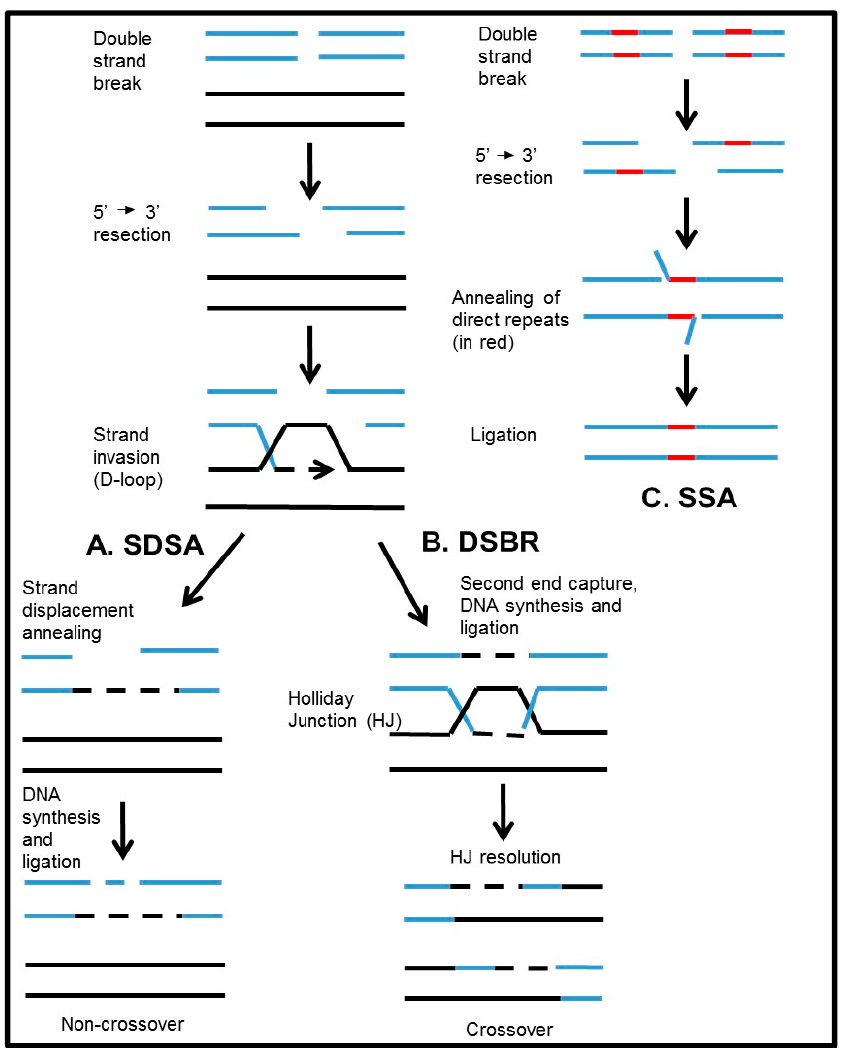
Figure 1. The DNA double-strand break (DSB) repair by Homologous Recombination (HR). The initial steps involve, 5’ to 3’ exonucleolytic processing of DSB ends to produce 3’-ssDNA tails, formation of RAD51-ssDNA filaments, search for homology and strand invasion into the homologous duplex DNA-template leading to the formation of displacement loops (D-loop). Then, HR may proceed either by ( A ) SDSA forming non-crossover products or ( B ) DSBR forming crossover products. When DSB are flanked by direct repeats, the break may be repaired by single strand annealing (SSA) mechanism mediated by repeated DNA sequences ( C